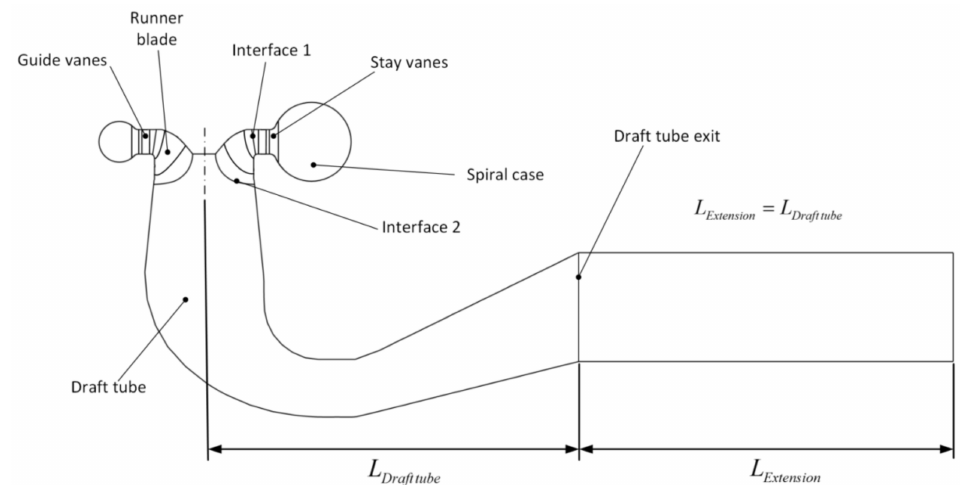
Figure 2. Computational domain of full turbine simulation.